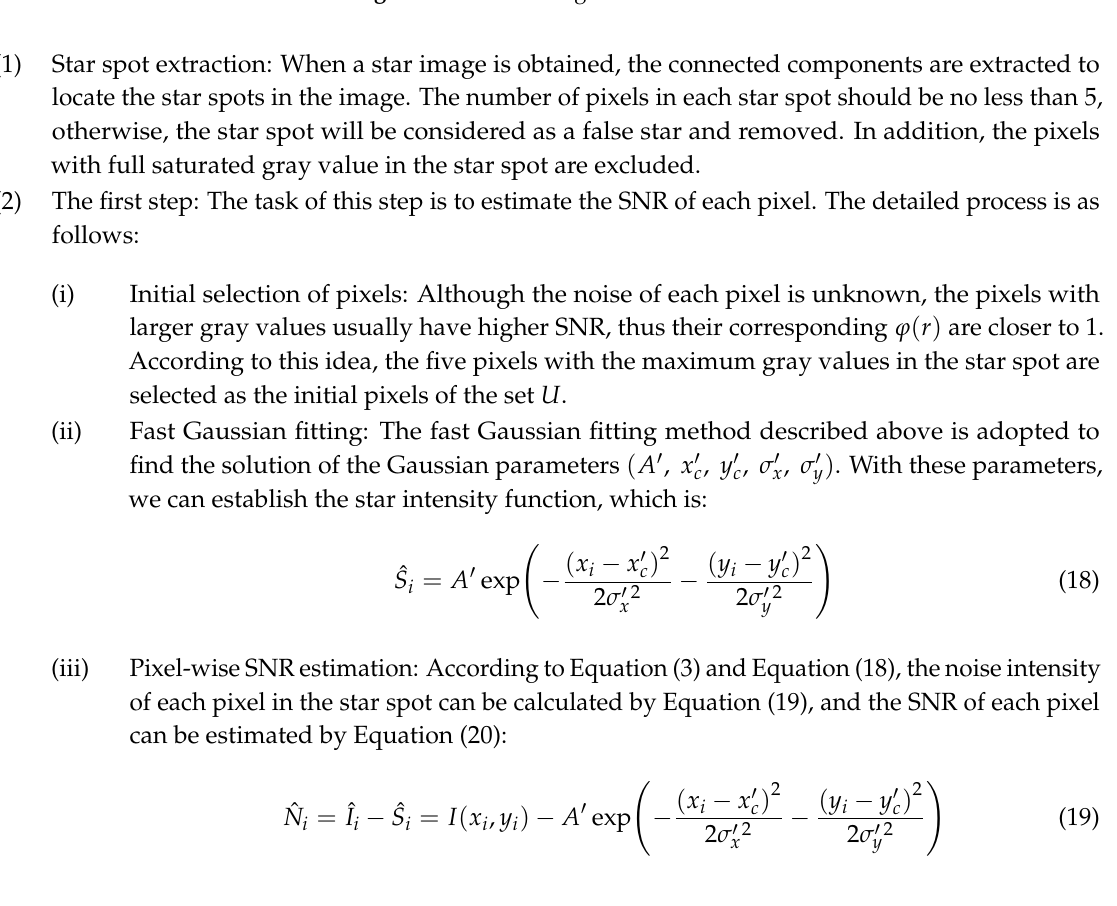
Figure 3. The flow diagram of the FGF.